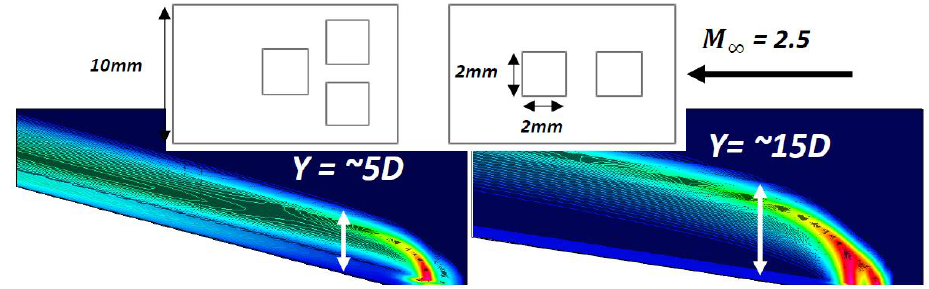
Figure 17. Case 2: Transverse jet penetration and wall distribution in terms of H 2 mass fraction (%H Mass).